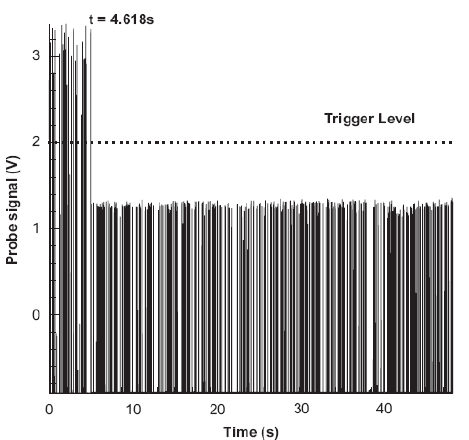
Figure 12. Probe signal during particle and bubble piercing (long time acquisition) [128]. As the probe tip was “contaminated” by small particles ( t ≤ 4.618 s), the light reflection decreased, which led to underestimated